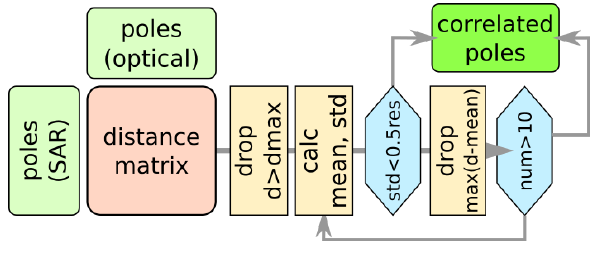
Figure 13. Overview of the correlation